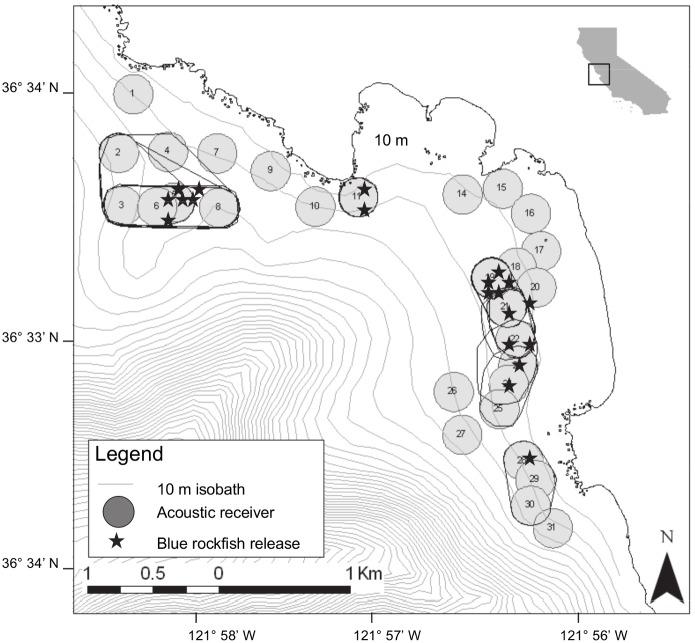
Release locations and estimated home range areas for tagged blue rockfish in the study area.Numbered grey circles represent receiver locations with estimated 150% of the h at liberty.